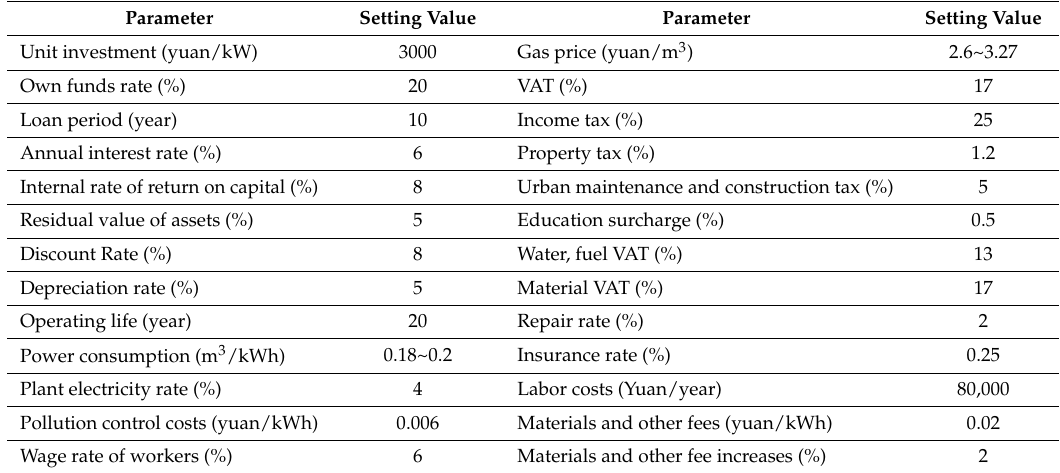
Table 5. Related parameters of centralized natural gas power generation (NGPG) projects (base load).